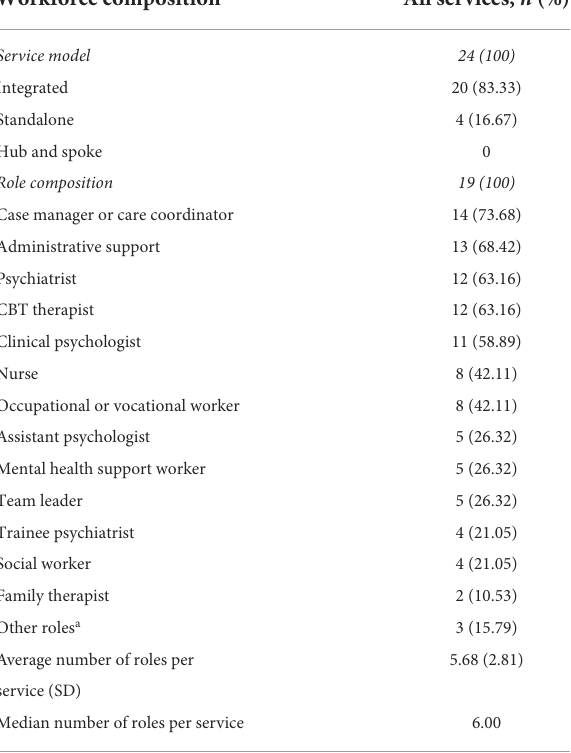
TABLE 1 Service